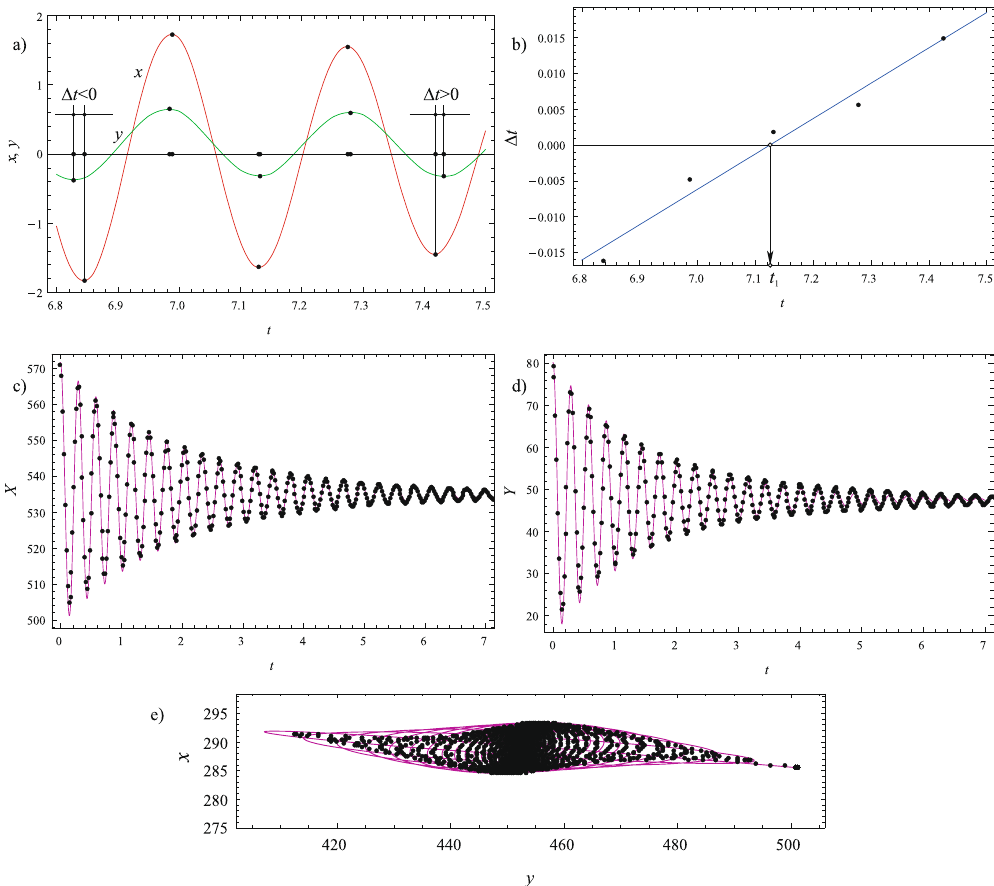
Figure 8. Marker 3: ( a ) Time differences between the extrema of x ( t ) and y ( t ); ( b ) Time difference versus time diagram with its zero value t 1 ; ( c ) Comparison of the transformed experimental results (magenta solid line) and the fitted numerical results (black dots) along the X -axis; ( d ) Comparison of the transformed experimental results (magenta solid line) and the fitted numerical results (black dots) along the Y -axis; ( e ) Comparisons for the